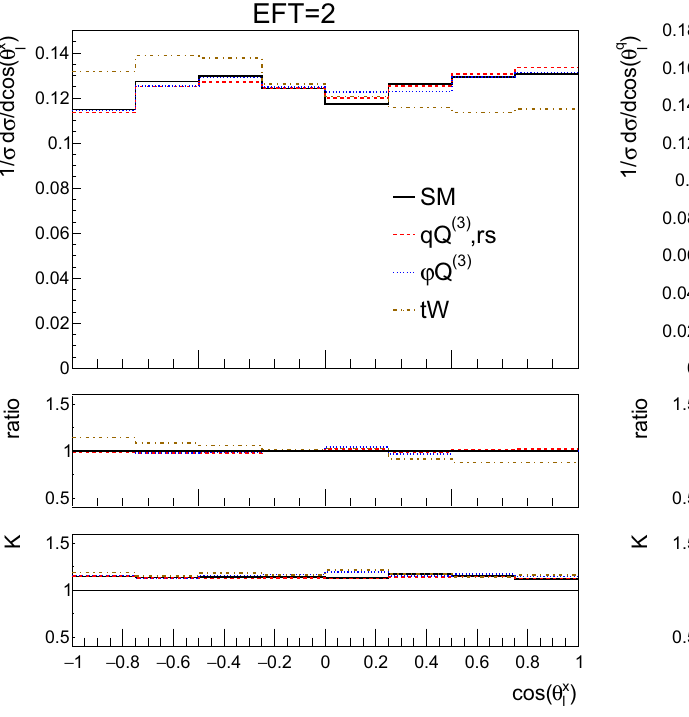
defined as the effect of the operator over the SM, the second inset shows > 10 the K -factor. Here additional cuts are applied on the leptons: p l T > 20 GeV and | η j | < 4 . 5 GeV and | η l | < 2 . 47 and jets: p j T